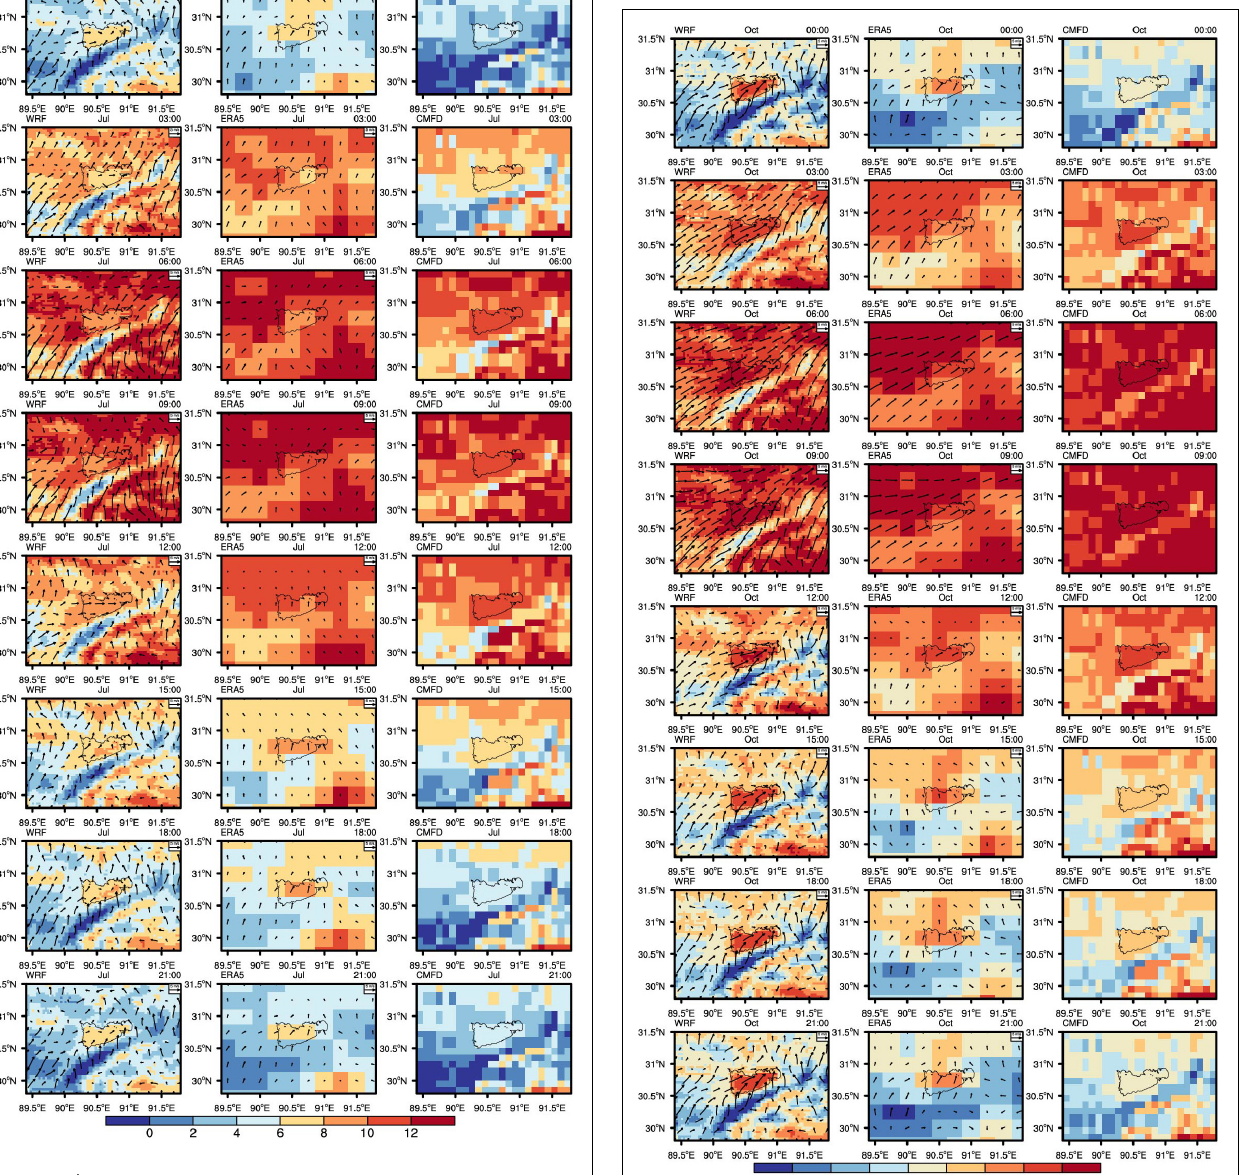
FIGURE 3 | Comparison of the monthly mean 3-h 2 m temperature (shading, units: ◦ C) and 10 m wind (vector, units: mm/s) between the WRF_lake simulation, the ERA5 and the CMFD data in July 2008. FIGURE 4 | Same as Figure 3 , but for October